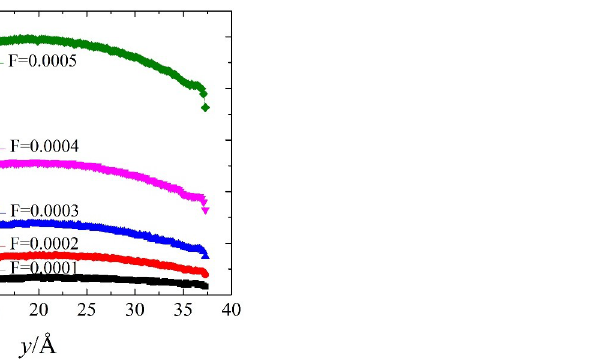
Fig 3. Electric field intensity and velocity distribution of driving force.